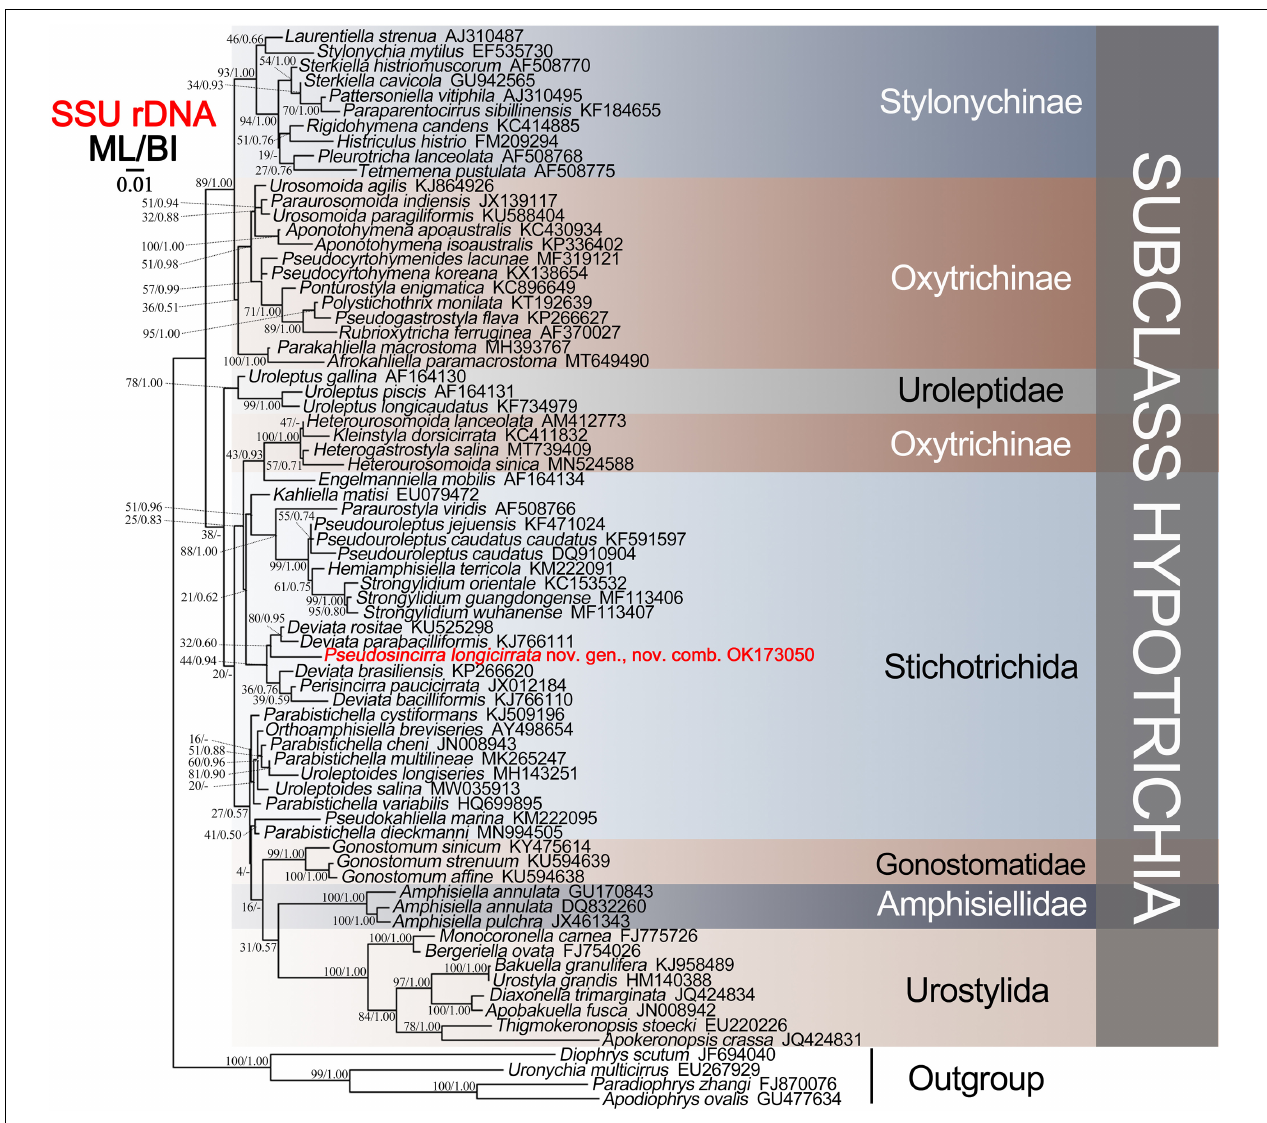
FIGURE 5 | Maximum likelihood (ML) tree based on the SSU rDNA sequence data. The newly sequenced Pseudosincirra longicirrata nov. gen. and nov. comb. are indicated in red. Numbers at the nodes represent the bootstrap values of ML and the posterior probabilities of Bayesian analysis (BI), respectively. A hyphen “-” indicates the disagreement between the BI tree and the reference ML tree. All branches are drawn to scale. The scale bar corresponds to 0.01 expected substitutions per